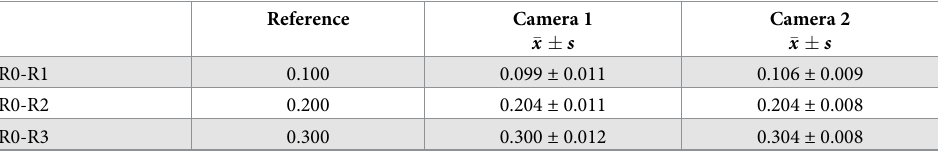
Table 2. Second validation experiment. Measured height for three steps from a reference step R0, using the camera 1 and the camera 2. All values in